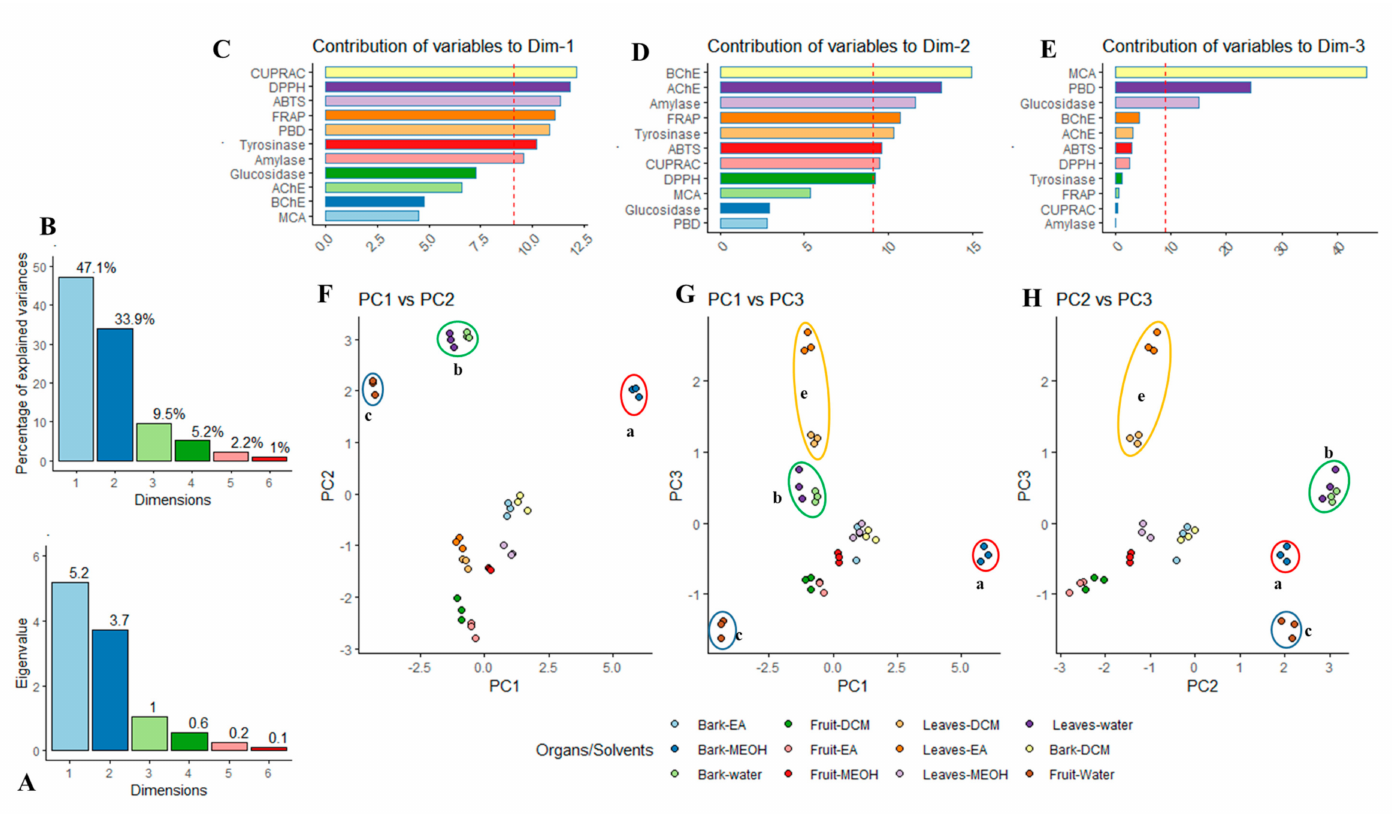
Figure 8. Unsupervised principal component analysis. ( A , B ), Scree plot of the eigenvalue and the percent of variance explained by each component; ( C – E ), Contribution of biological assays to each component; ( F – H ), Projection of the samples on the 1st, 2nd and 3rd factor planes (the dot (a–e) in Figure F–H indicates the groups in the tested